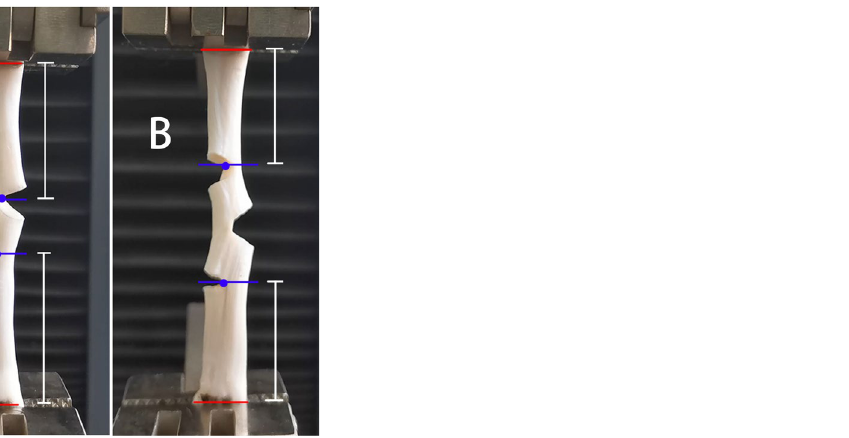
Figure 3. Tendons in the biomechanical tensile test. ( A ) double hemisection. ( B ) triple hemisection. The distance between the incisions in A and B was 1 cm. Red line: clamping line. Blue lines: planes of the hemisections farthest apart. Blue dot: vertex of angle formed by hemisection deformation. The plane of the hemisection was marked as a line passing through the vertex of the angle formed by hemisection deformation and perpendicular to the long axis of the tendon. The distance between the red and blue lines (white line) is the distance between the clamp line and nearest